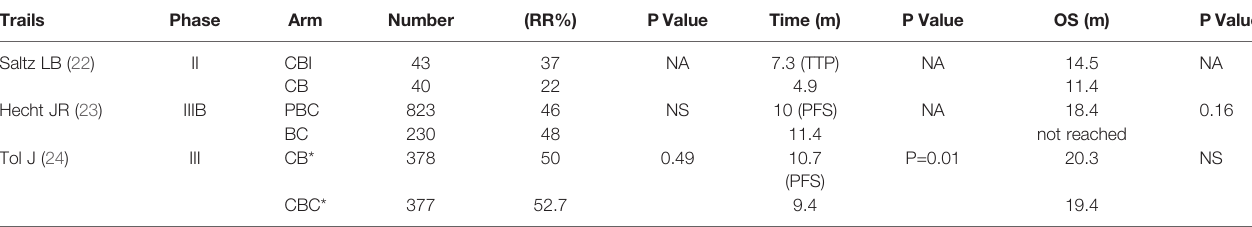
TABLE 1 | Combination treatment of anti-EGFR and anti-VEGF drugs in patients with metastatic colorectal Cancer.